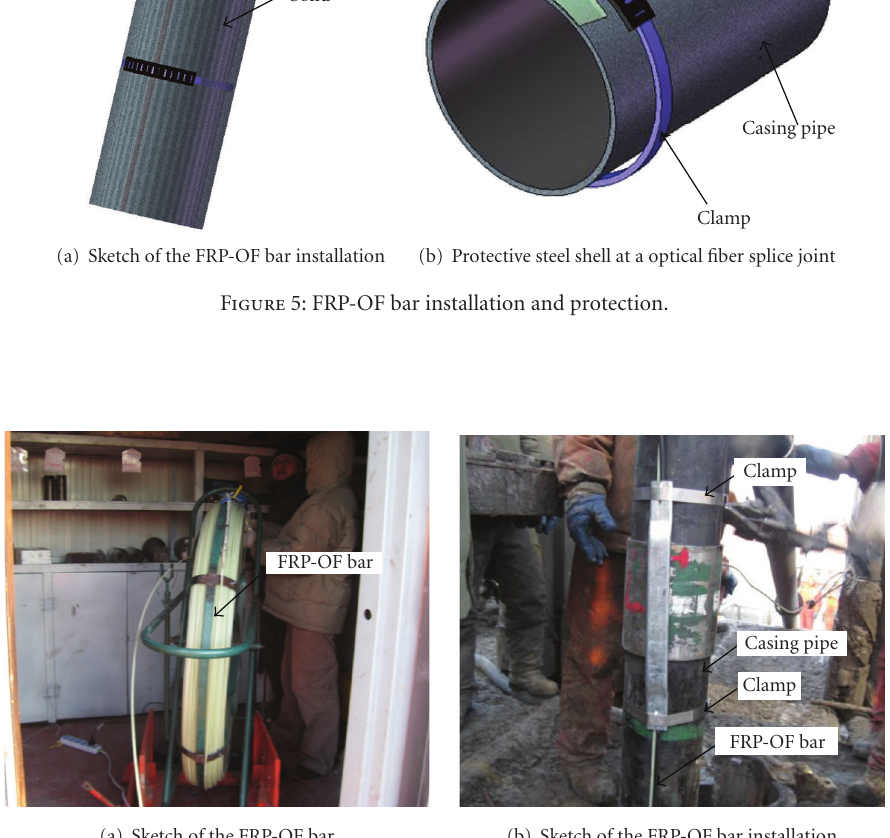
Figure 6: Sketch of the FRP-OF bar